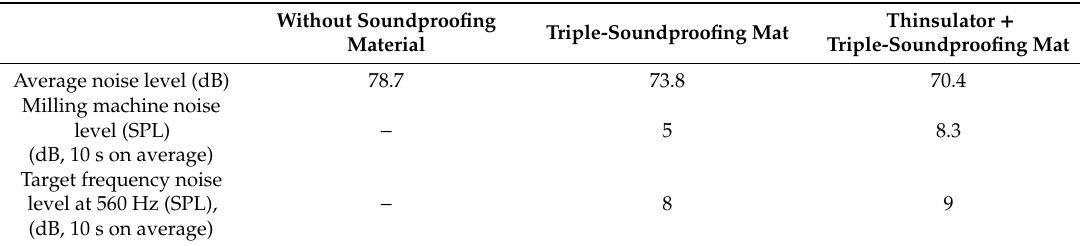
Table 2. Summarized results of the noise reduction level.